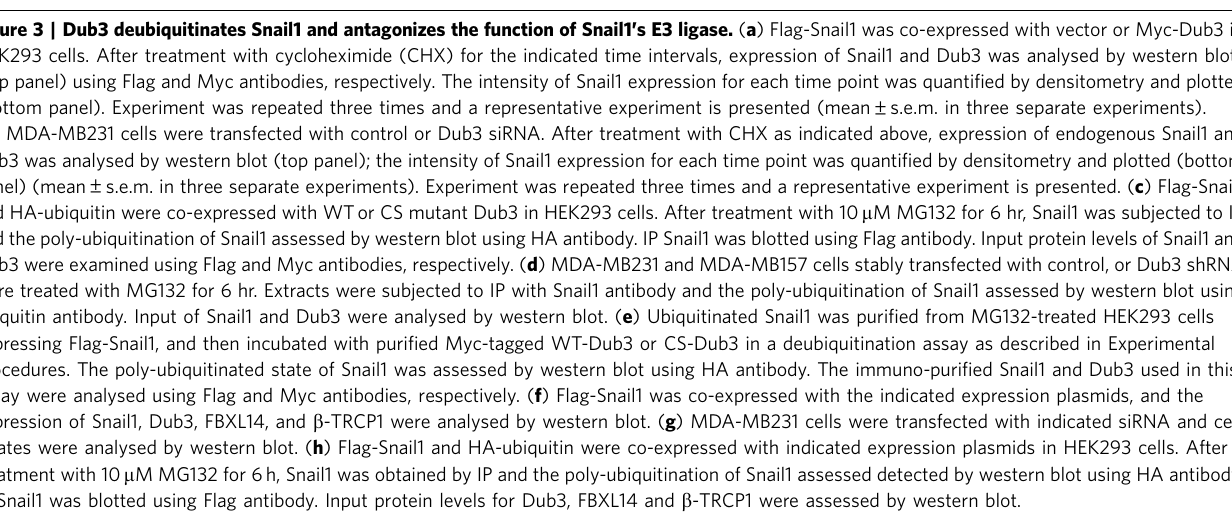
Figure 3 | Dub3 deubiquitinates Snail1 and antagonizes the function of Snail1’s E3 ligase. ( a ) Flag-Snail1 was co-expressed with vector or Myc-Dub3 in HEK293 cells. After treatment with cycloheximide (CHX) for the indicated time intervals, expression of Snail1 and Dub3 was analysed by western blot (top panel) using Flag and Myc antibodies, respectively. The intensity of Snail1 expression for each time point was quantified by densitometry and plotted (bottom panel). Experiment was repeated three times and a representative experiment is presented (mean ± s.e.m. in three separate experiments). ( b ) MDA-MB231 cells were transfected with control or Dub3 siRNA. After treatment with CHX as indicated above, expression of endogenous Snail1